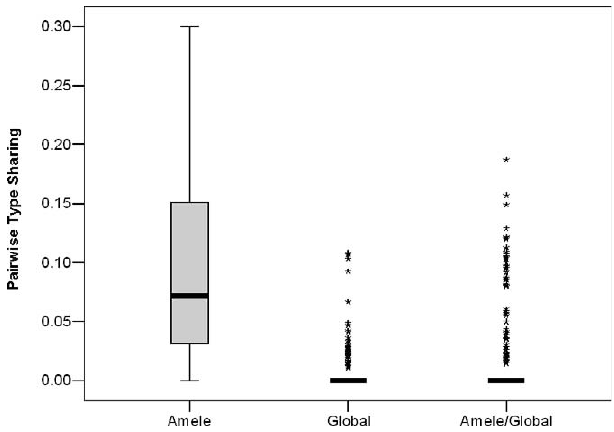
Figure 2. PTS among DBL a Repertoires from Amele and Global Populations PTS was plotted for pairs of Amele DBL a repertoires, global DBL a repertoires, and Amele DBL a repertoires paired with global DBL a repertoires. The median (thick line), interquartile range (boxes), approximate 95% sampling interval (whiskers ¼ 1.5 times the inter- quartile range), and suspected outliers (asterisks) are shown. The raw data for these plots can be found in Figure